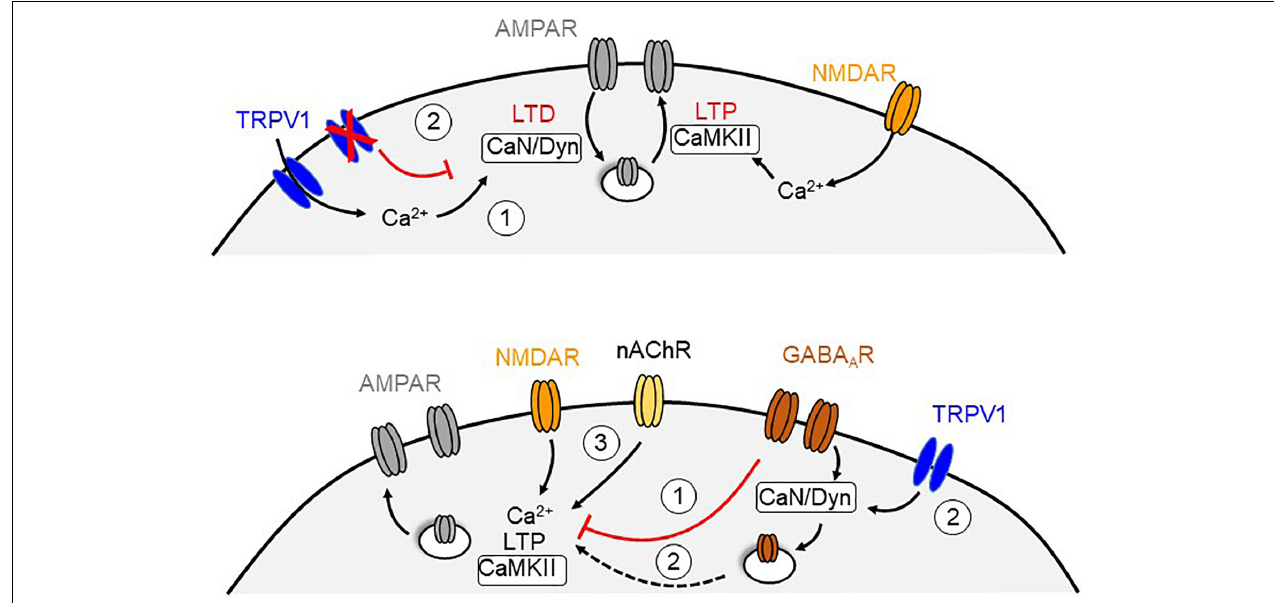
FIGURE 2 | Potential mechanisms for TRPV1-dependent metaplasticity at central synapses. Top, Calcium influx through TRPV1 channels triggers a form of postsynaptic LTD that require endocytosis of AMPARs, which may counterbalance the level of N-methyl-D-aspartate receptor (NMDAR) dependent LTP (1). In contrast, blockade or genetic deletion of TRPV1 channels recovers NMDAR-mediated LTP that may be due to the absence of TRPV1-LTD (2). Bottom, NMDAR-dependent LTP can be reduced by activation of GABA A Rs (1). Activation of TRPV1 channels could triggers a calcineurin (CaN) and dynamin (Dyn)-dependent endocytosis of GABA A Rs that remove the inhibitory suppression of the LTP (2). Exogenous activation of nicotinic acetylcholine receptors (nAChR) may oppose the influence of GABAergic inhibition and rescue LTP in the absence of TRPV1 likely by increasing calcium levels